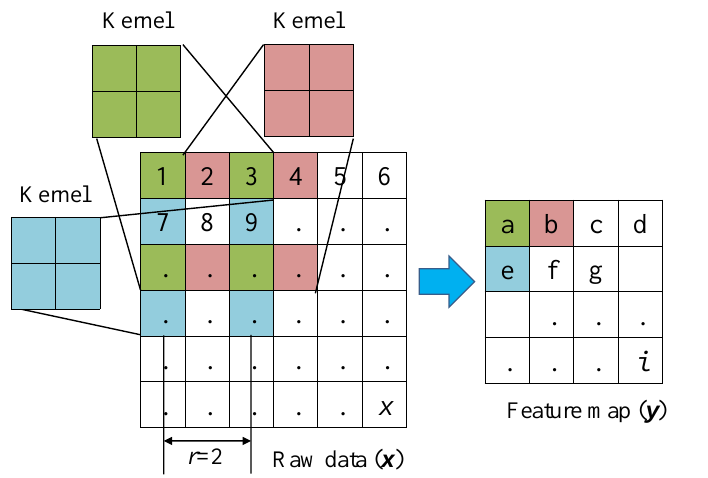
Figure 3. The DeepLab_v3+ network.